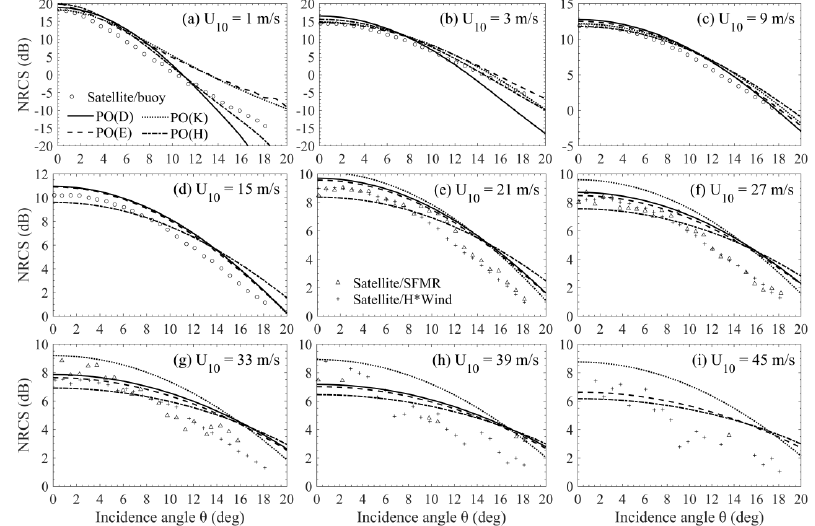
Figure 2. Examples of predictions of the physical optics (PO) model with D (solid curve), E (dashed curve), K (dotted curve), and H (dash-dotted curve) spectra input and their comparison with the bin-averaged normalized radar cross-section (NRCS) measurements. Results are plotted as functions of incidence angle for wind speeds of 1, 3, 9, 15, 21, 27, 33, 39, and 45 m / s. Symbols for the reference dataset are as follows: Circles are the collocated satellite / buoy data; triangles are the satellite / stepped-frequency microwave radiometer (SFMR) data; and pluses represent the satellite / H*Wind